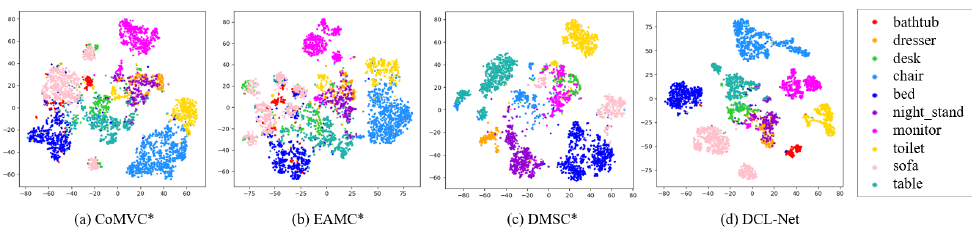
Figure 2. The t-SNE visualization results of the latent 3D shape features on the ModelNet10